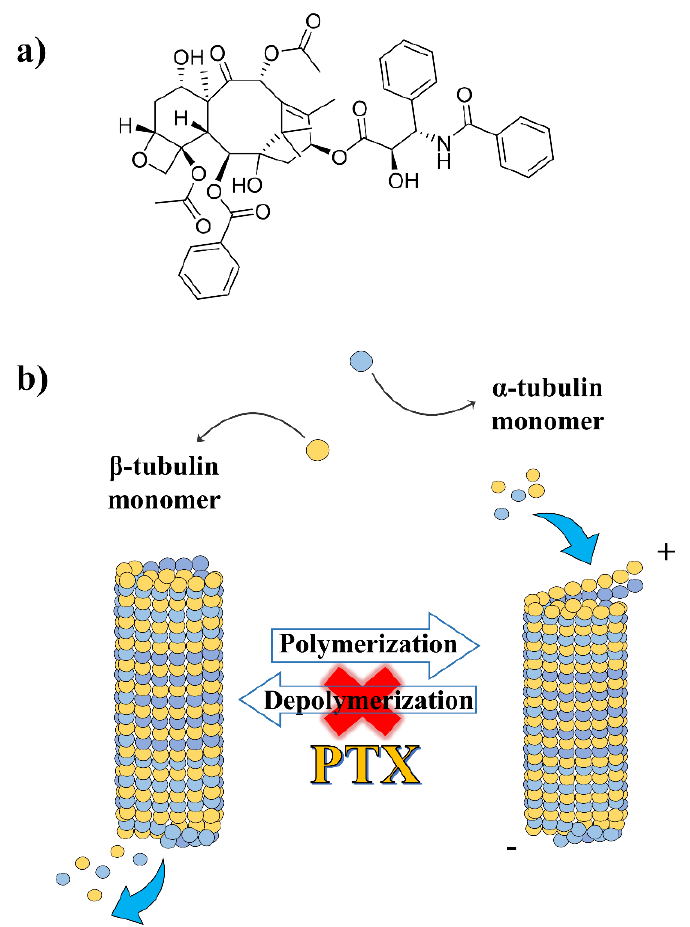
Figure 1. Chemical structure of paclitaxel (PTX) ( a ) and schematic representation of its mechanism of action ( b ).